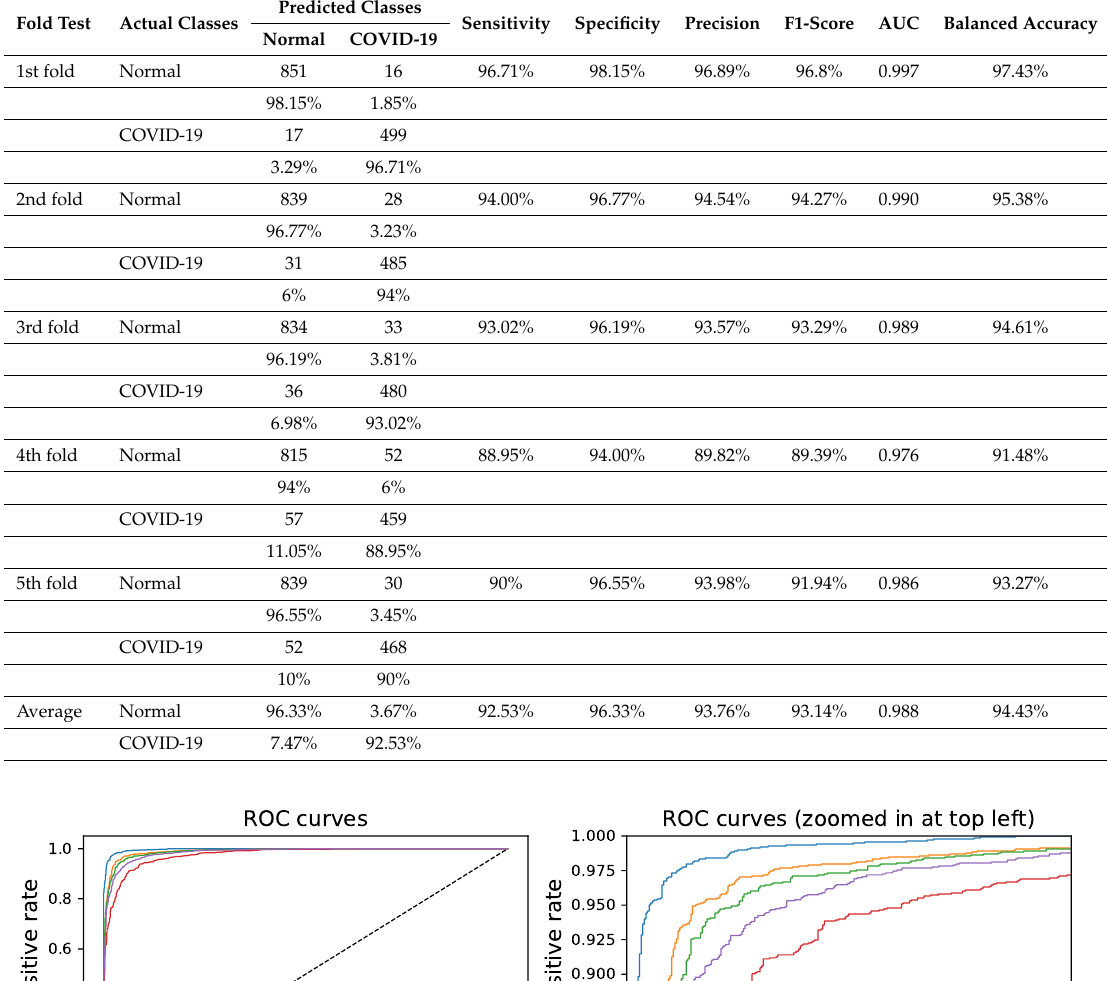
Table 1. Cross-validation results for each of the folds, where sensitivity, specificity, precision, F1-score, AUC, and balanced accuracy are reported. The average of these metrics over the different folds are also shown.